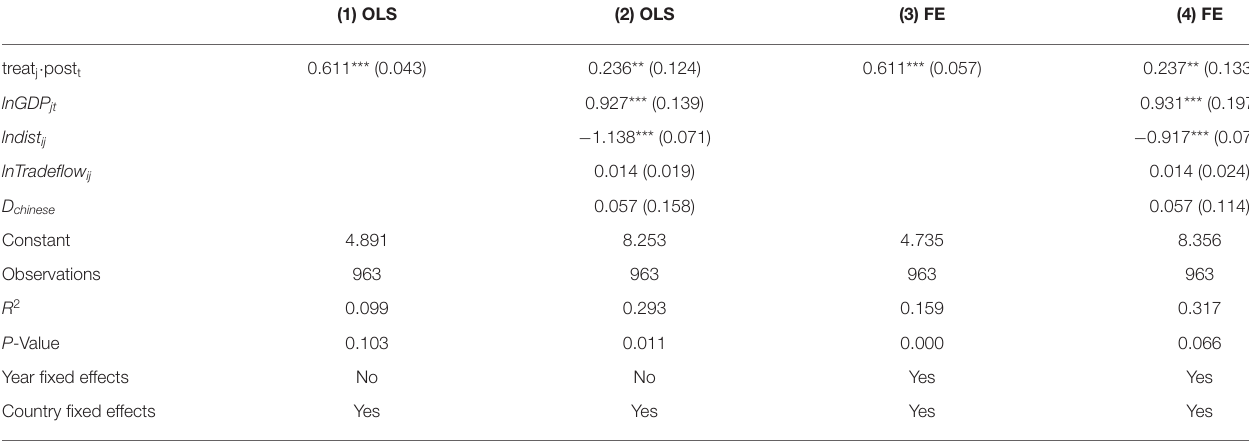
TABLE 5 | Estimated results.